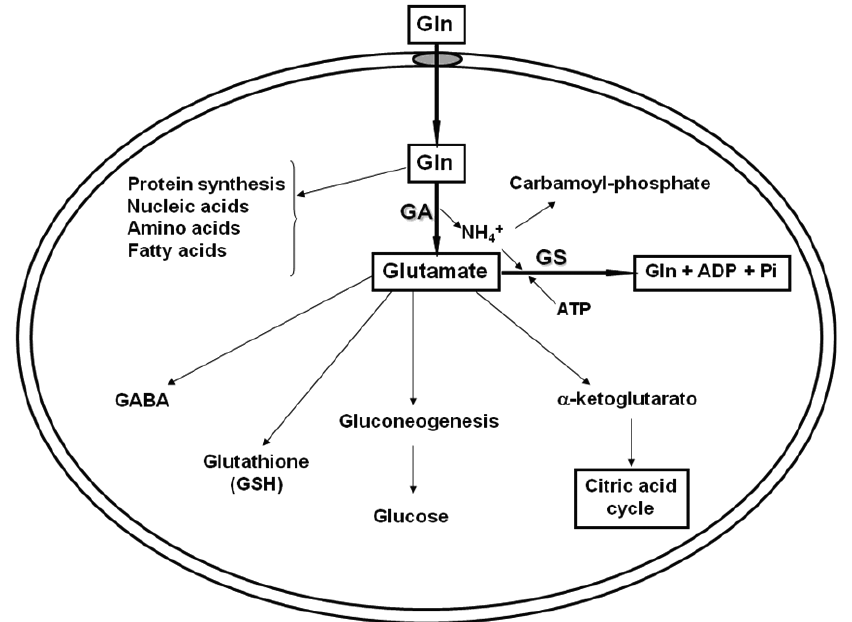
Fig. 1 – Metabolism and anabolism of glutamine (Gln). Glutamine is synthesized by the action of glutamine synthetase (GS) and degraded by mitochondrial glutaminase (GA). Glutamine can be synthesized by most tissues in glutamate and ammonia. Ammonia can be used to form carbamoyl phosphate. Glutamate can form α -ketoglutarate, glucose in the liver and kidneys, gluthatione in most of cells, and Gamma-aminobutyric acid (GABA) in